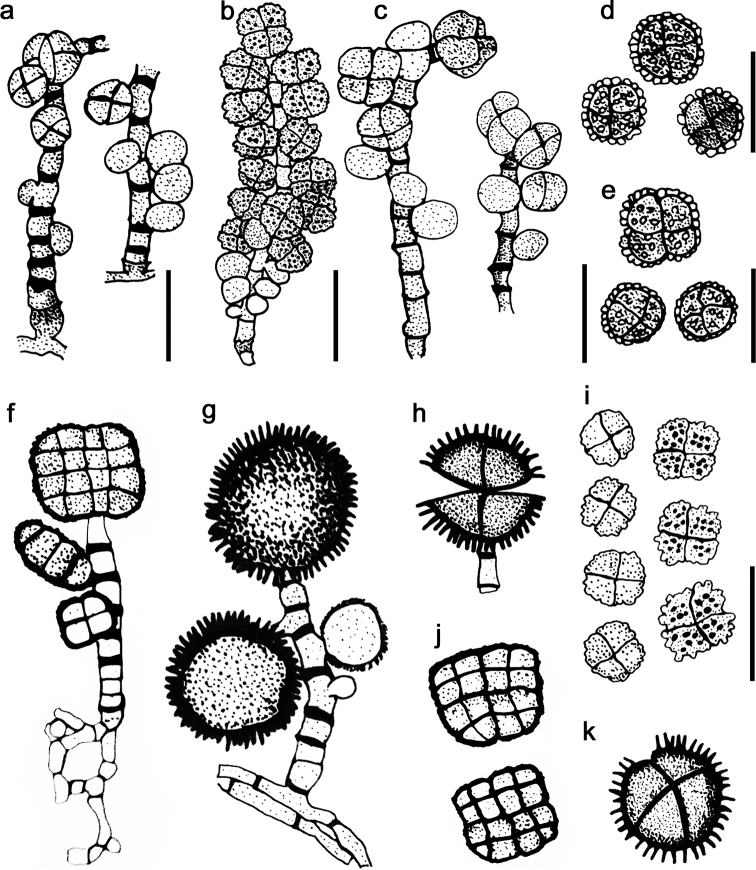
Morphology of conidia and conidiophores of previously described Dictyoarthrinium species a, dD.
microsporumb, iD.
synnematicumc, eD.
lilliputeumf, jD.
africanumg, h, kD.
rabaulense. Scale bars: 20 μm (a, c, d, e); 10 μm (b, i). Magnification × 650 (f, g, h, j, k). Redrawn from Rao and Rao (1964), Ellis (1971), Kobayasi et al. (1971) and Somrithipol (2007).